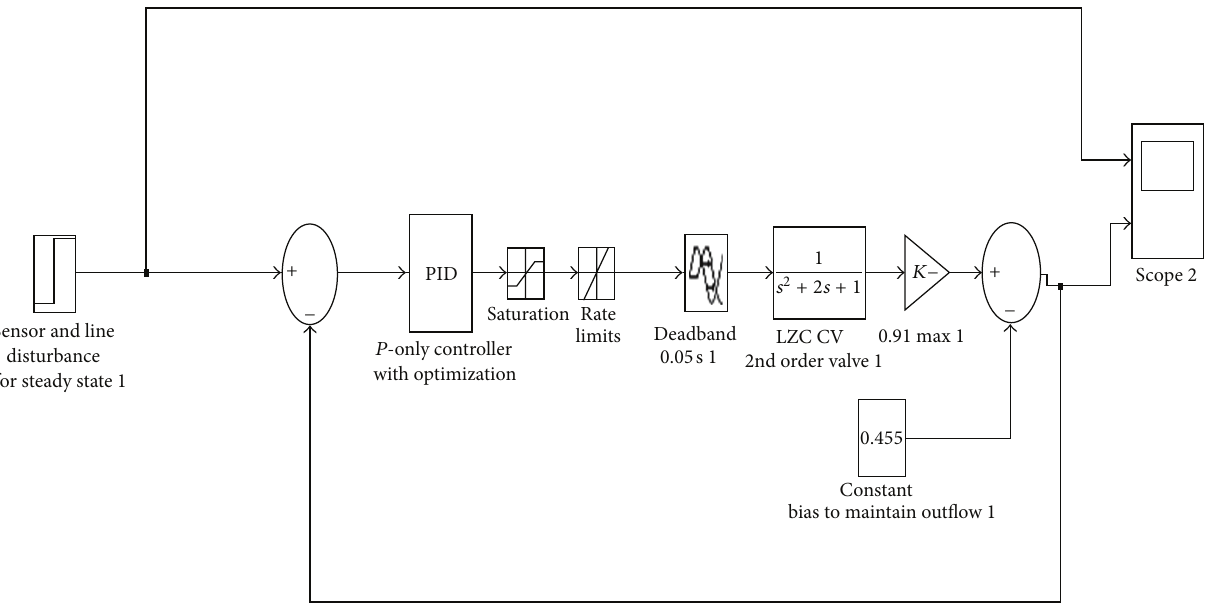
Figure 7: Optimized LZ controller set-up in